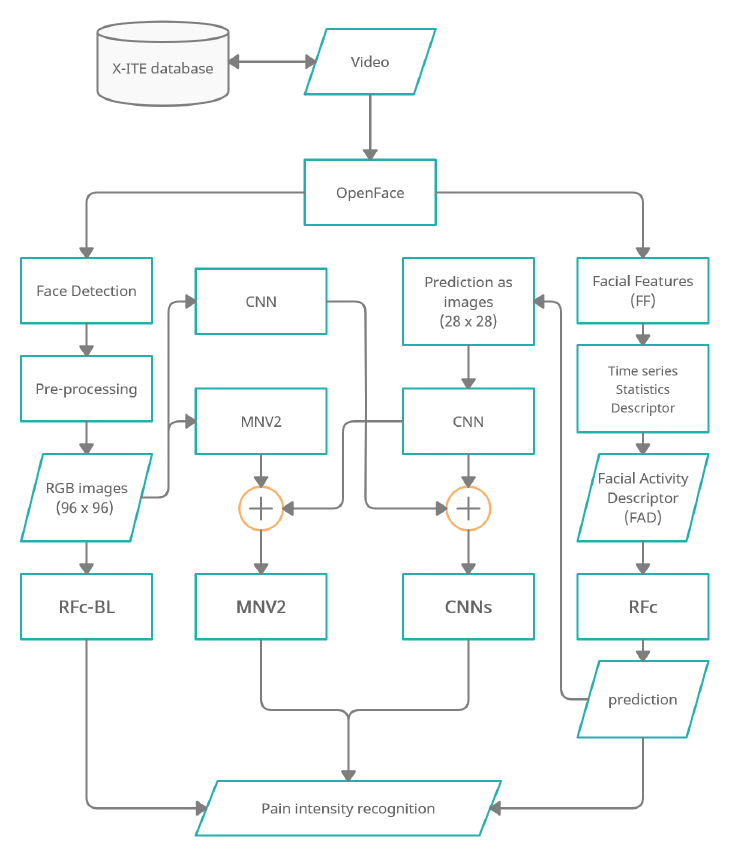
Figure 1. Overview of pain recognition system variants “RFc-BL”, “MNV2”,“CNNs” and